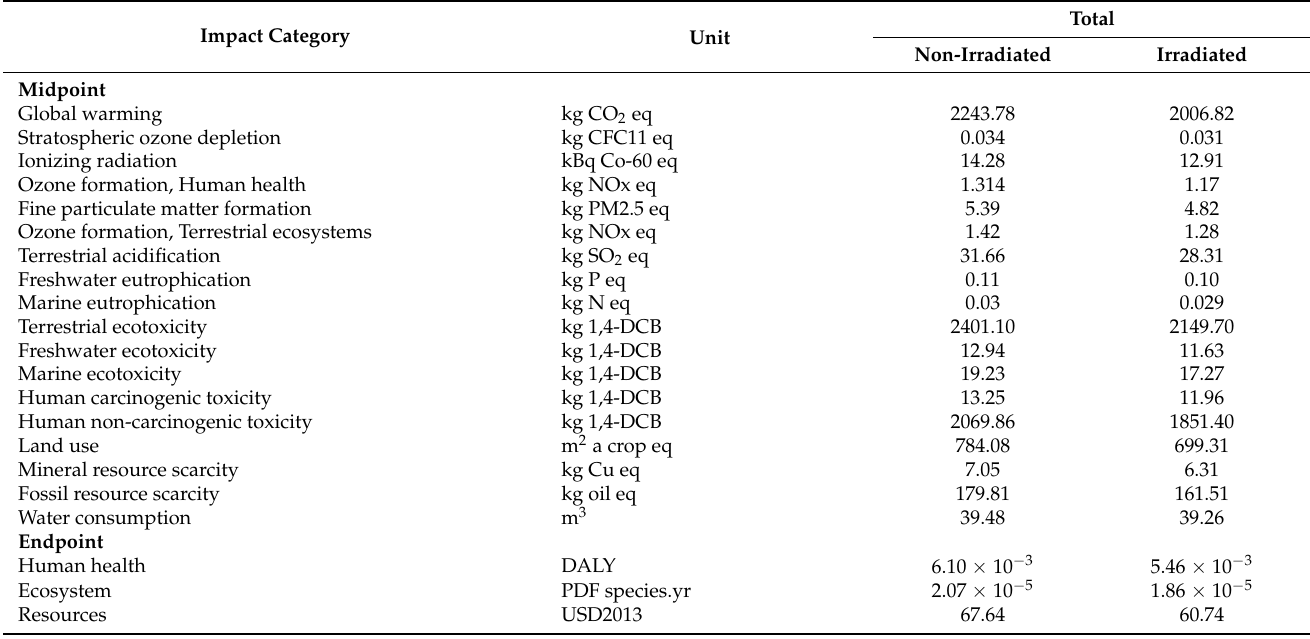
Table 2. The impact categories at the midpoint and endpoint